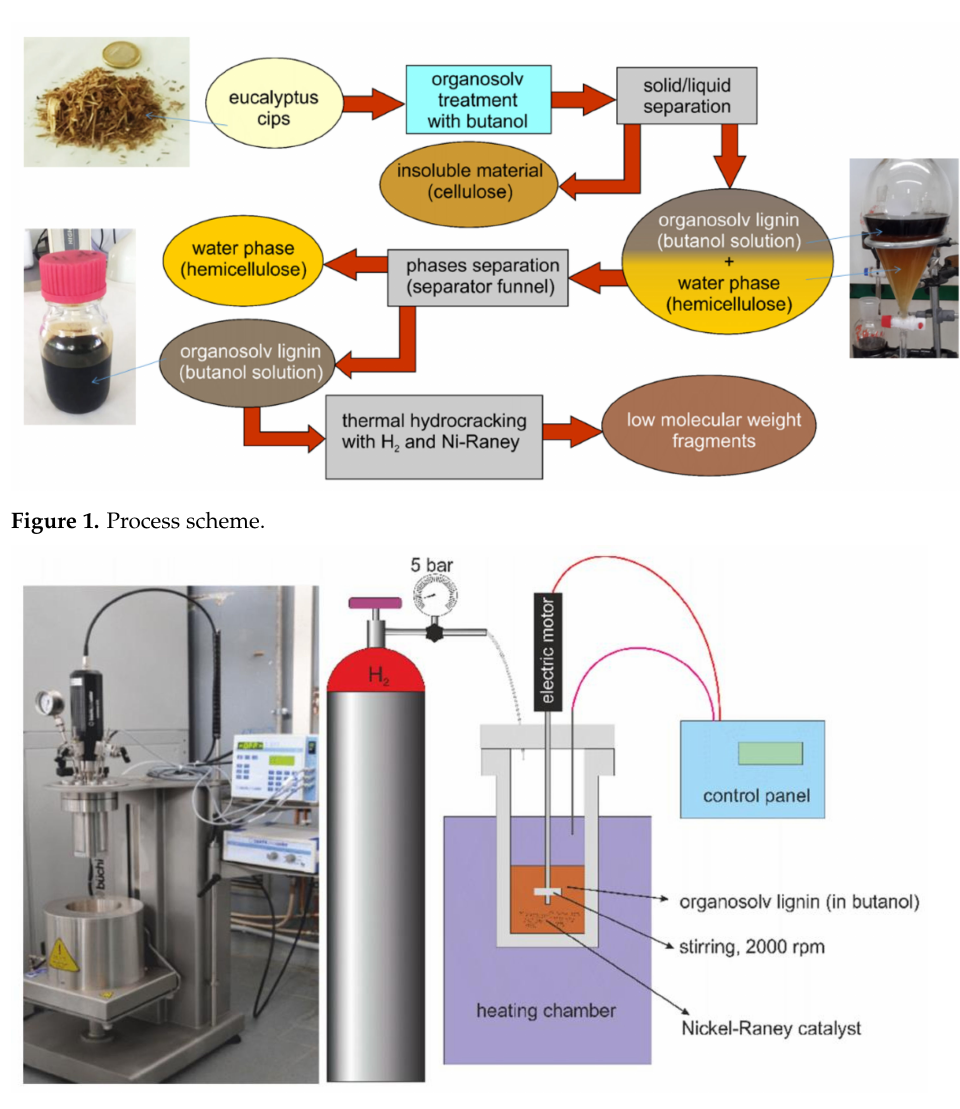
Figure 2. Parr reactor picture and scheme of the experimental